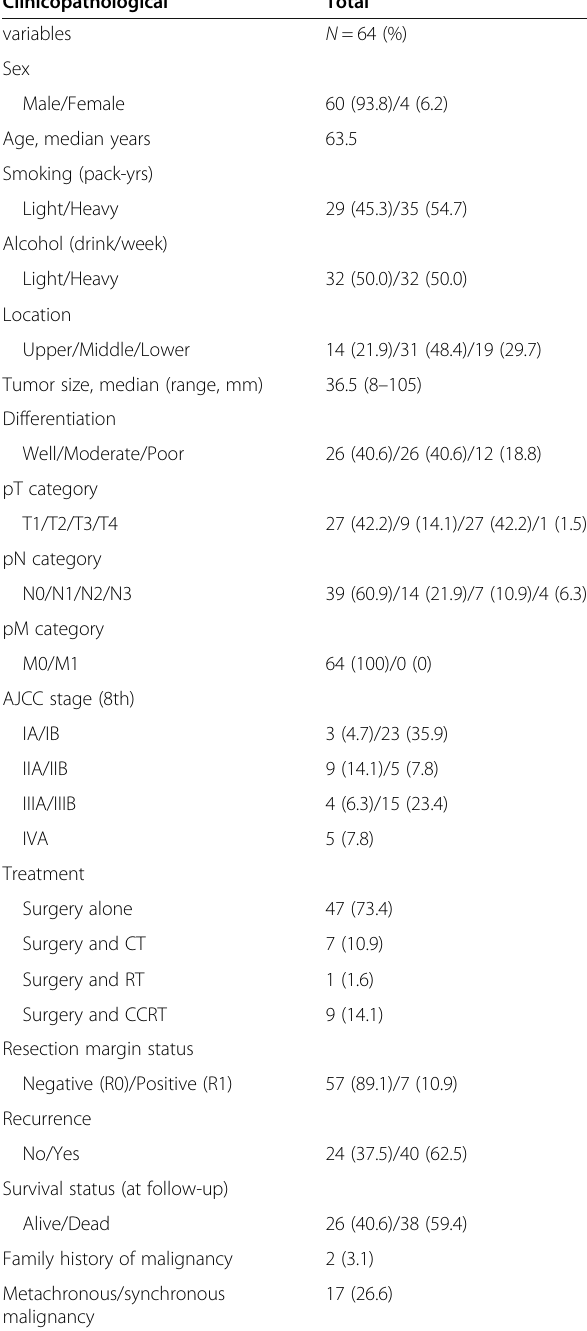
Table 1 Baseline patient characteristics of patients with esophageal squamous cell carcinoma